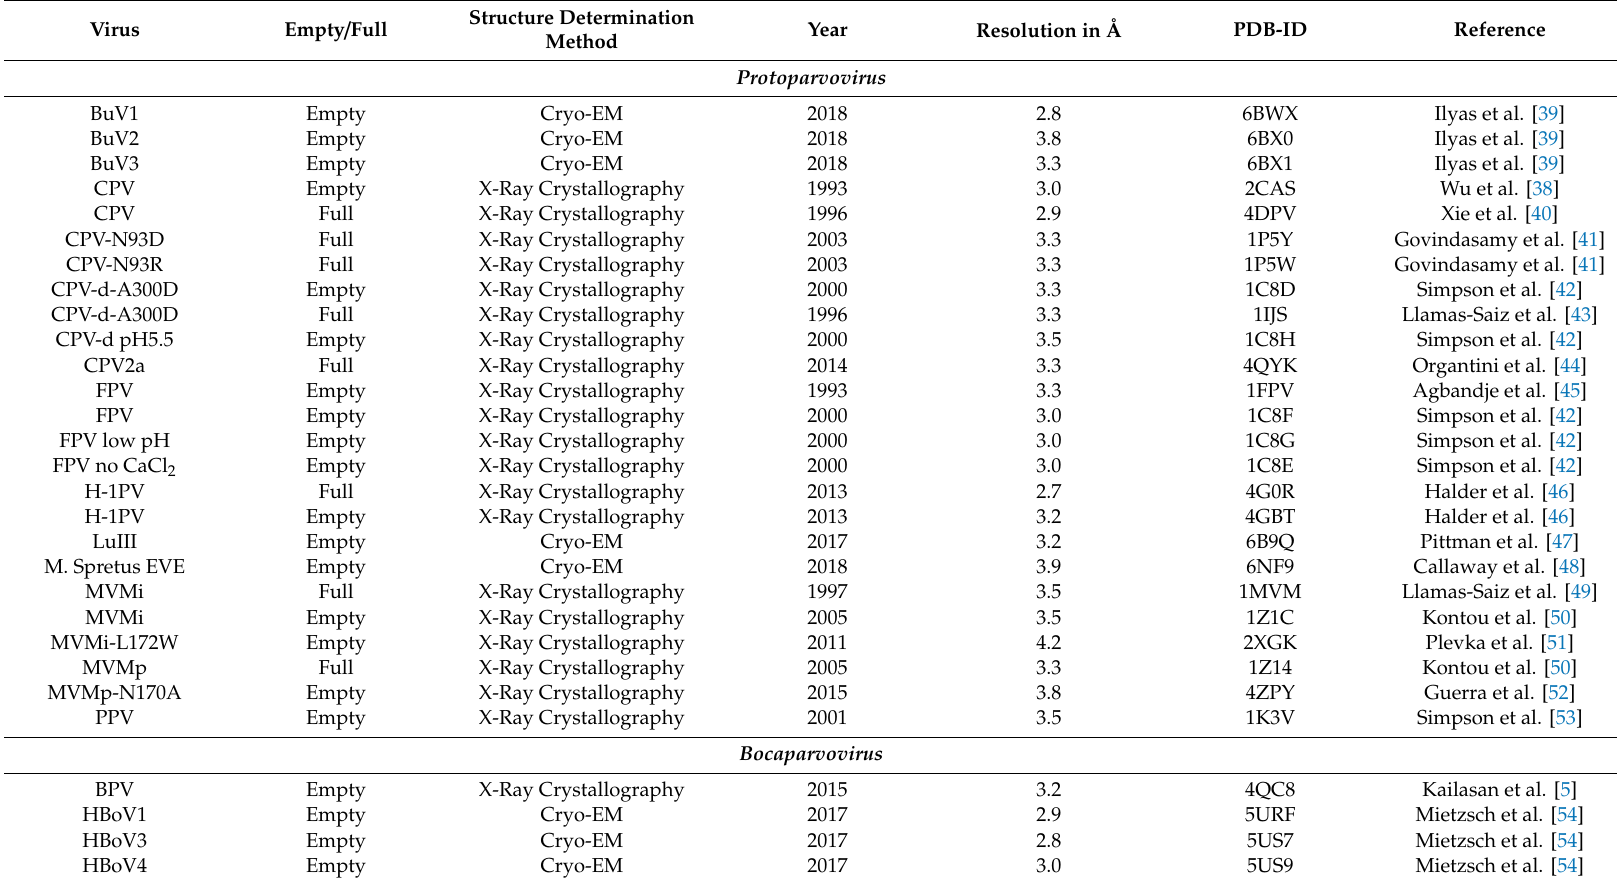
Table 1. Summary of deposited Parvovirinae capsid